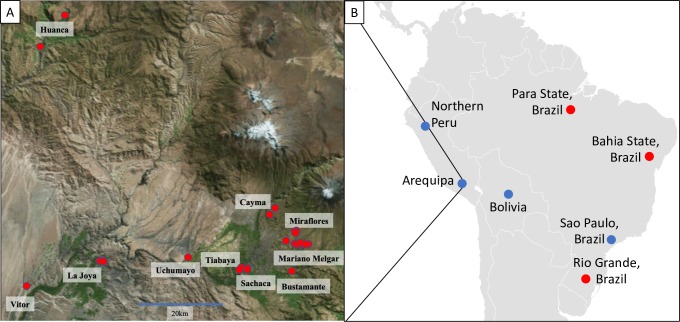
Spatial distribution of samples collected in (A) Arequipa, Peru and (B) South America. (A) The names of ten districts from which T. cruzi samples were collected are labeled. Houses from which isolates were collected are represented by red dots. Map of Arequipa was obtained from https://landlook.usgs.gov and QGIS v. 2.18 [75] was used to plot sample locations. (B) The sites where isolates were collected are represented by blue dots. Neighboring towns of La Esperanza, Campo Florido, and Naranjal are represented by a single blue dot labeled “Northern Peru”. Sequences obtained from NCBI database are represented by red dots. Map of South America was modified from https://commons.wikimedia.org/wiki/Atlas_of_the_world. Figure was modified from Berry et al. (2019) [33].